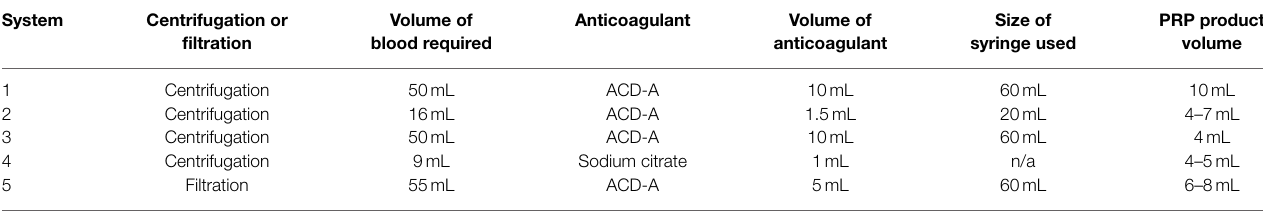
TABLE 1 | PRP system protocols summary .